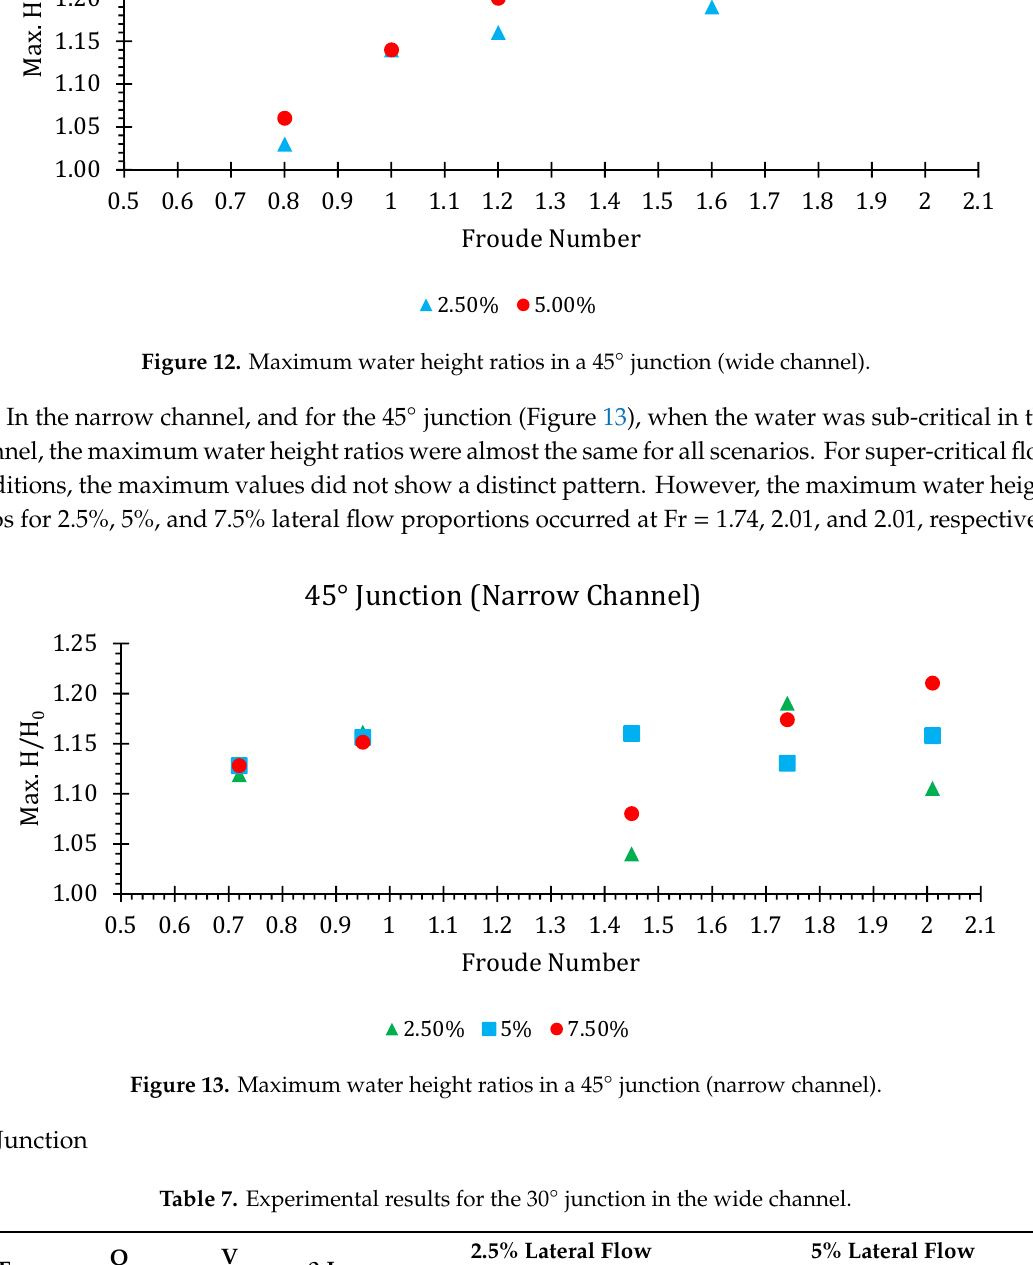
Table 7. Experimental results for the 30° junction in the wide channel.